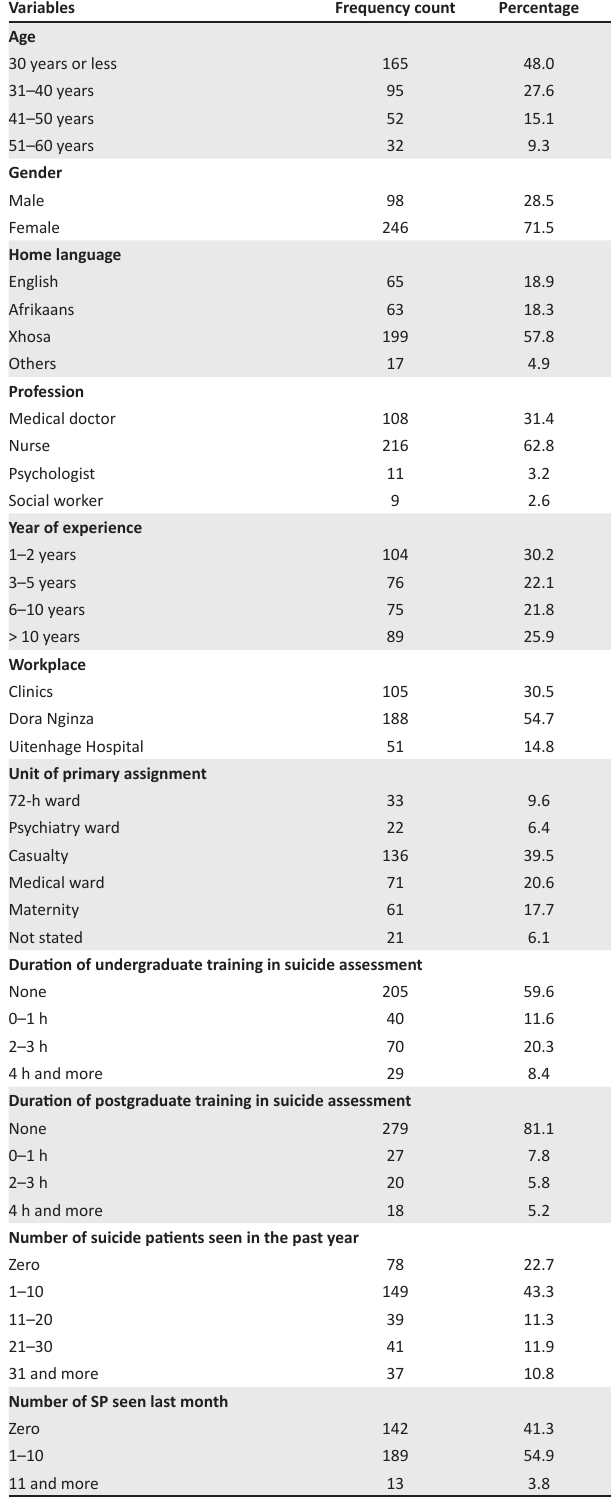
TABLE 1: Background characteristics of healthcare workers included in the study.